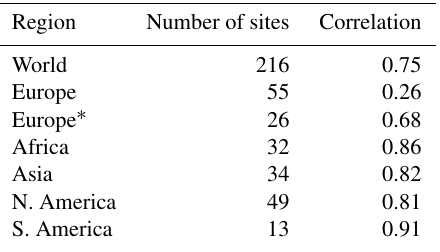
Table 5. Correlation in modelled and observed yearly site-mean AOT. Region Number of sites Correlation World 216 0.75 Europe 55